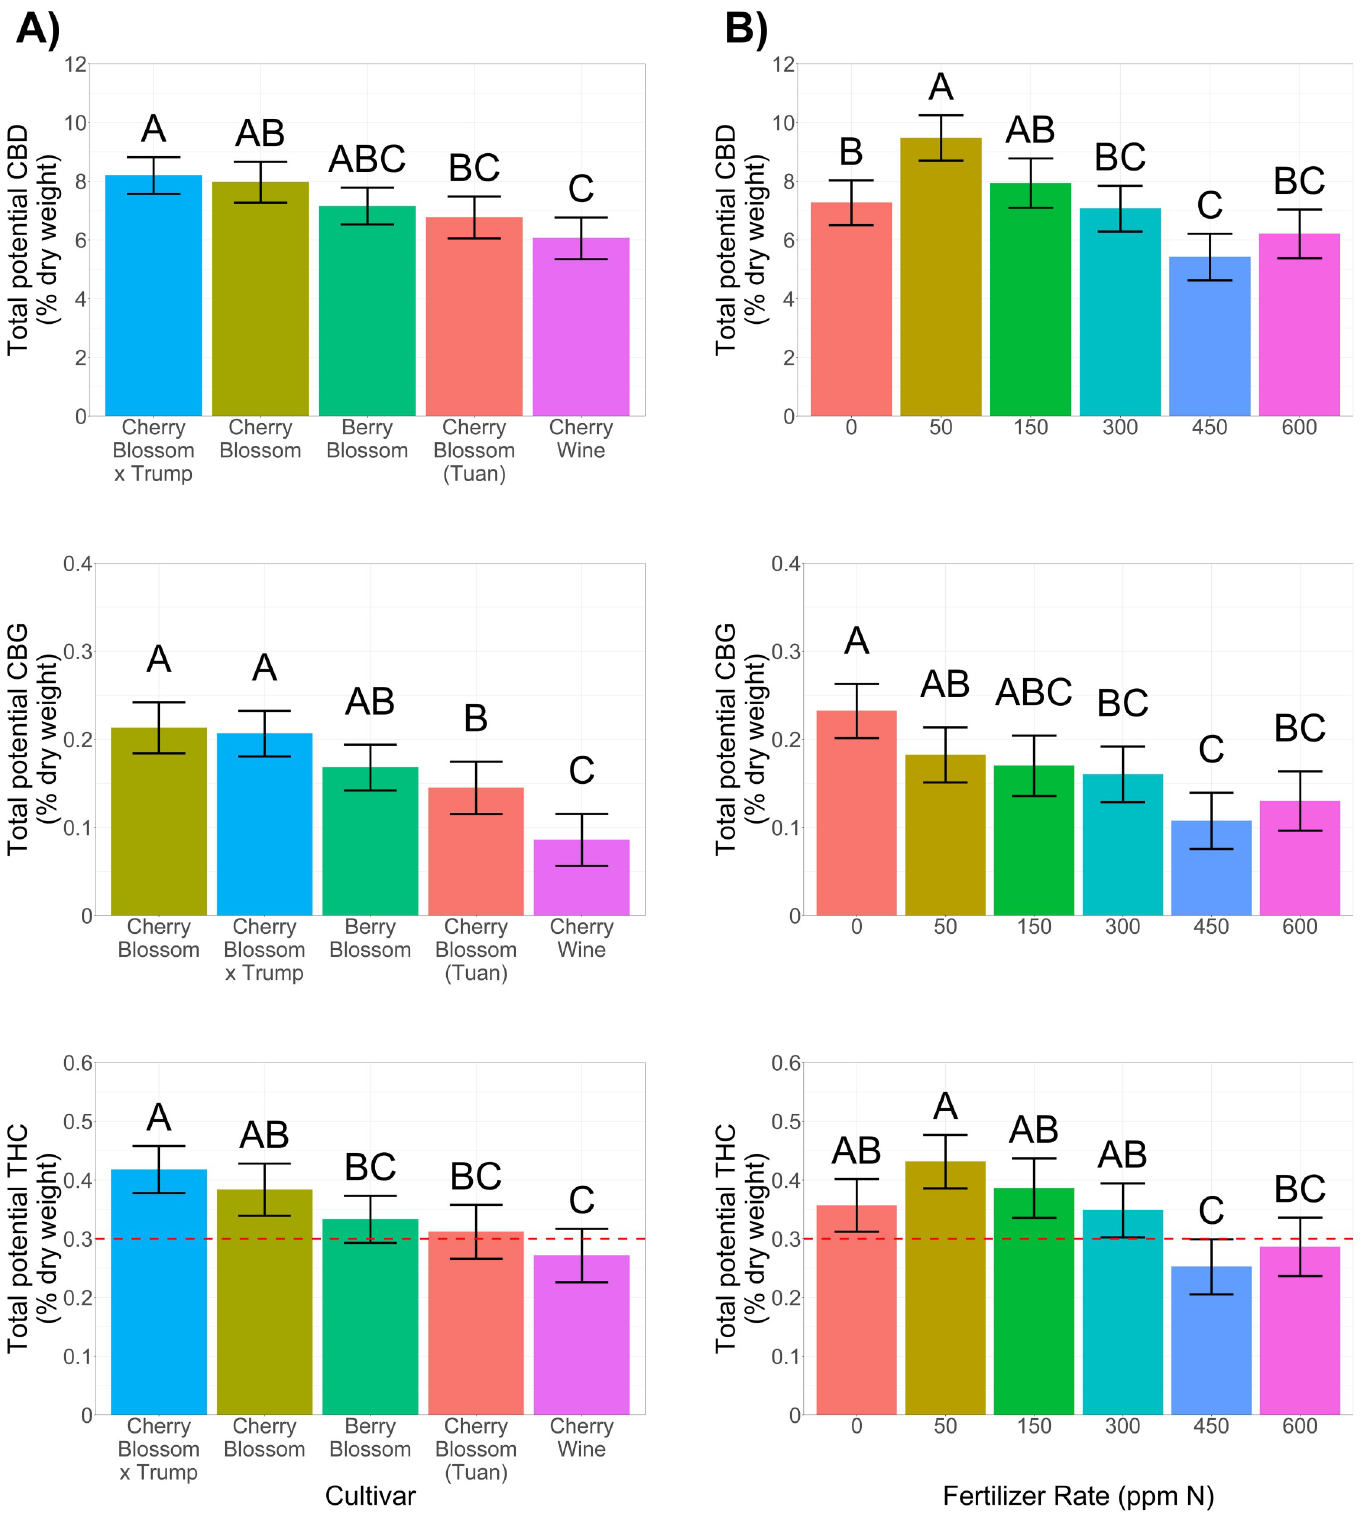
Fig 5. Bars represent fertilizer rate best linear unbiased estimator (BLUE) values total potential (carboxylated form + 0.877[acid form]) cannabidiol (CBD), cannabigerol (CBG), and tetrahydrocannabinol (THC) concentrations between [A] cultivars and [B] fertilizer rates. Error bars depict 95% confidence intervals and connecting letters indicate statistical differences using Tukey’s HSD ( α = 0.05). Horizontal red line indicates the THC compliance threshold of 0.3% total potential THC.